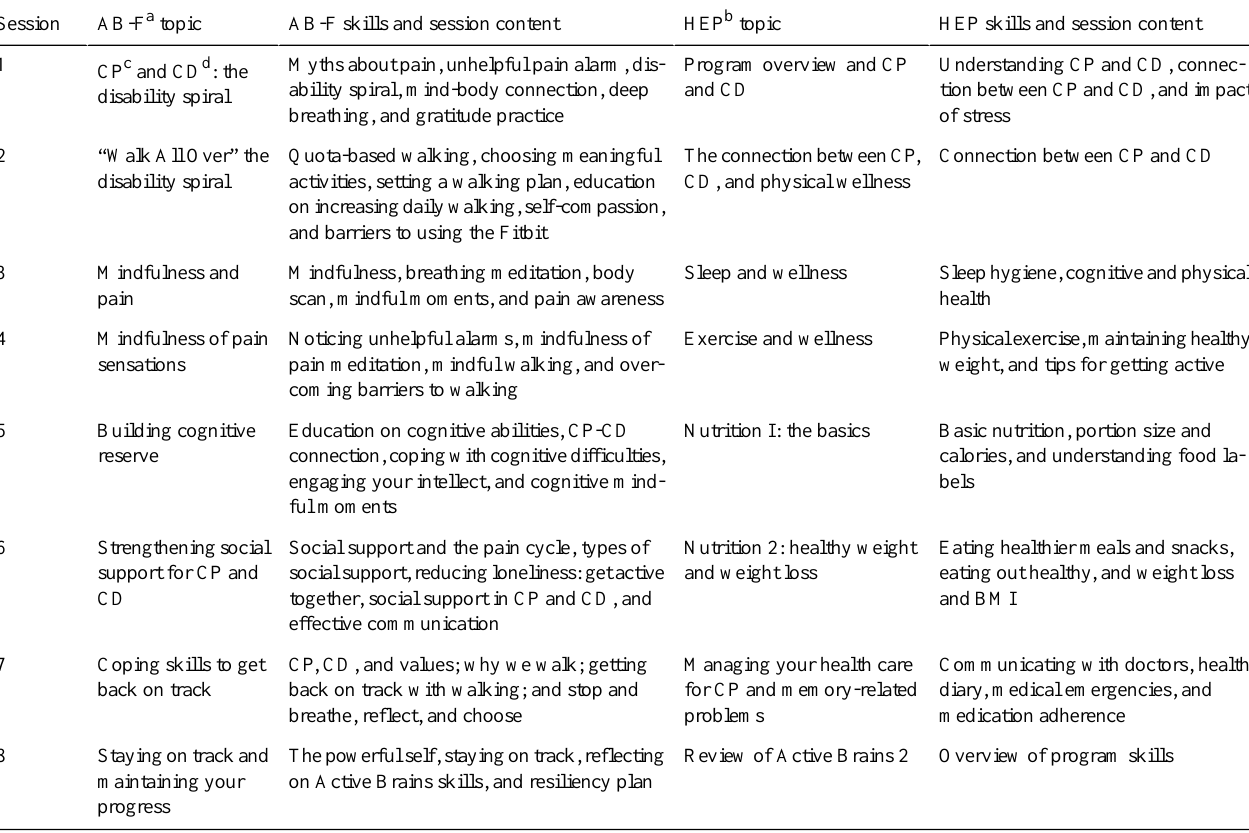
Table 1. Session outline for the Active Brains-Fitbit and health enhancement program for older adults with chronic pain and cognitive